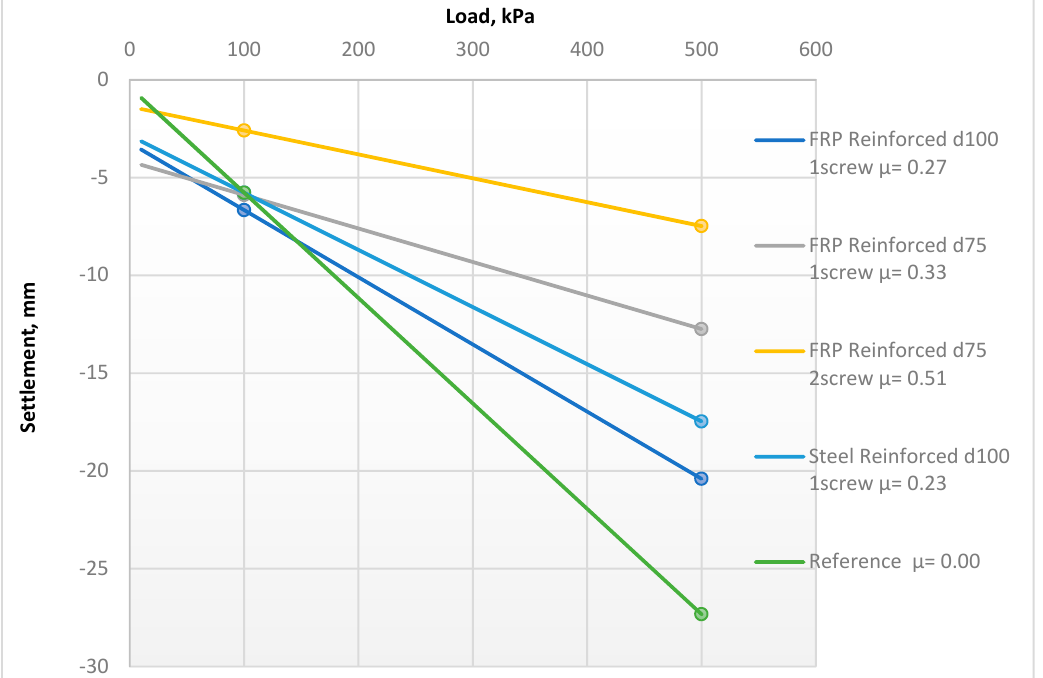
Figure 7. The in situ PLT elastic deformation before and after the reinforcement for varied reinforcement areas.